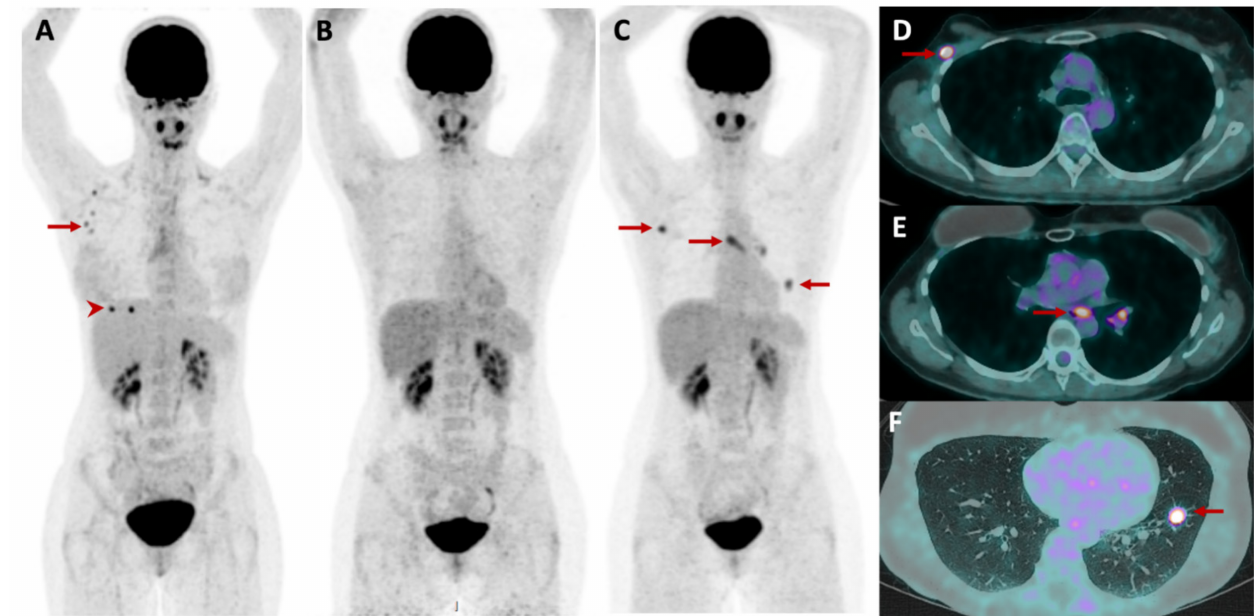
Figure 2. 33-year-old patient with advanced NST breast carcinoma. The maximum intensity pro- jection at initial diagnosis ( A ), showed two breast lesions with focal FDG uptake (arrowhead) and pathological radiotracer uptake by axillary lymph nodes (arrow). The patient was in complete remission after treatment by surgery, chemotherapy and adjuvant radiotherapy ( B ), followed by of hormonotherapy. Five years later the patient relapsed ( C , arrows) with new metastatic lesions, as shown by the fusion images, in the right axilla ( D , arrow), in mediastinal and left hilar lymph nodes ( E , arrow) and in the lung ( F , arrow). The patient was further treated by chemotherapy and local therapy of the metastatic sites: surgery of the right axilla and radiotherapy of the lymph nodes and pulmonary lesion, considered as an oligometastatic